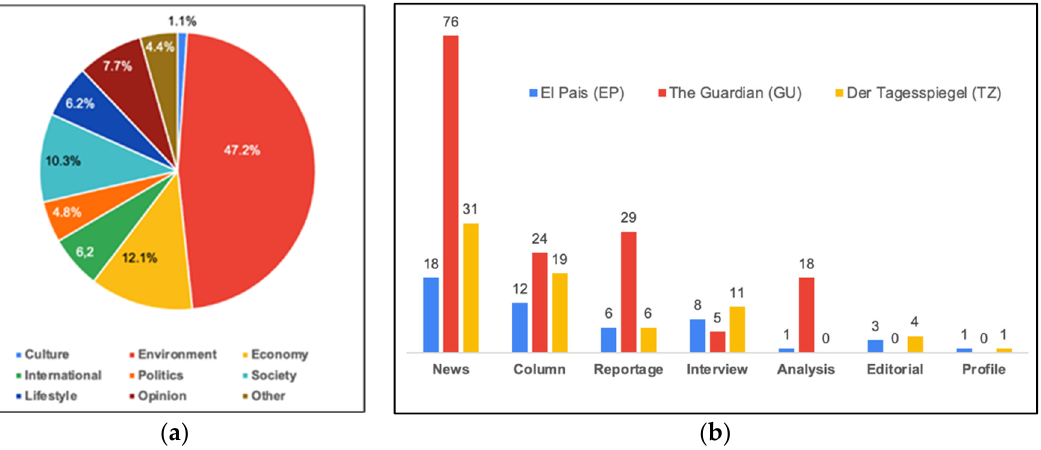
Figure 4. ( a ) Percentage of items published by section included in the general sample; ( b ) percentage of items published by media outlet in each section (%).